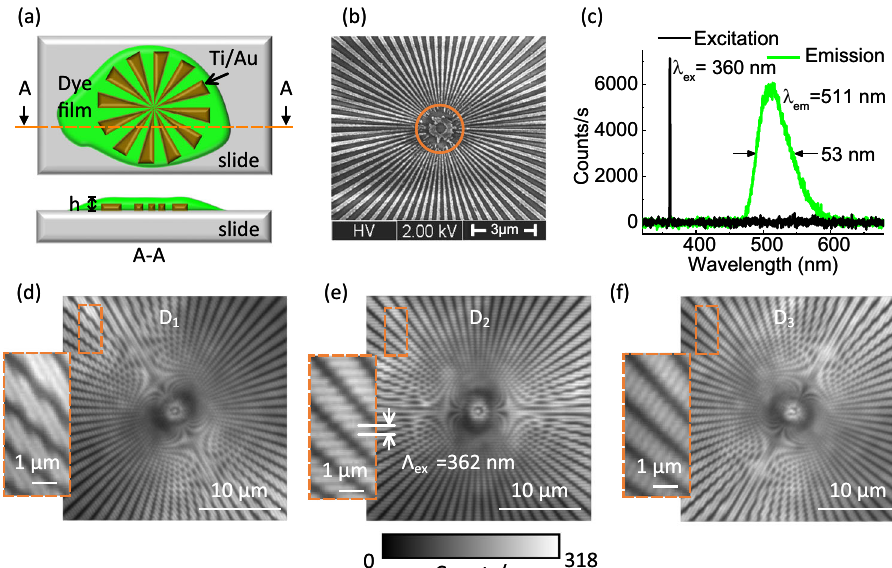
Fig.2|Fluorescentsectorstartarget.a Schematicofthemetalsectorstartarget on borosillicate microscope slide with green fl uorescent dyes coated on top. Thickness of the coated dye layer: h =300nm. b Scanning electron micrograph of the metal sector target. The orange solid circle points out the position where thegratingpitchalongthecircleequalsto100nm.Theimagingisindependently